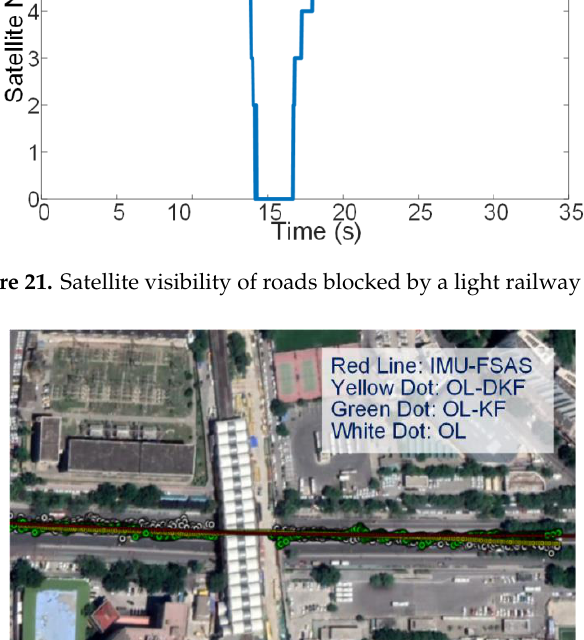
Figure 21. Satellite visibility of roads blocked by a light railway test. Figure 22. Trajectories of OL-DKF, OL-KF, OL and IMU-FSAS of roads blocked by a light railway.